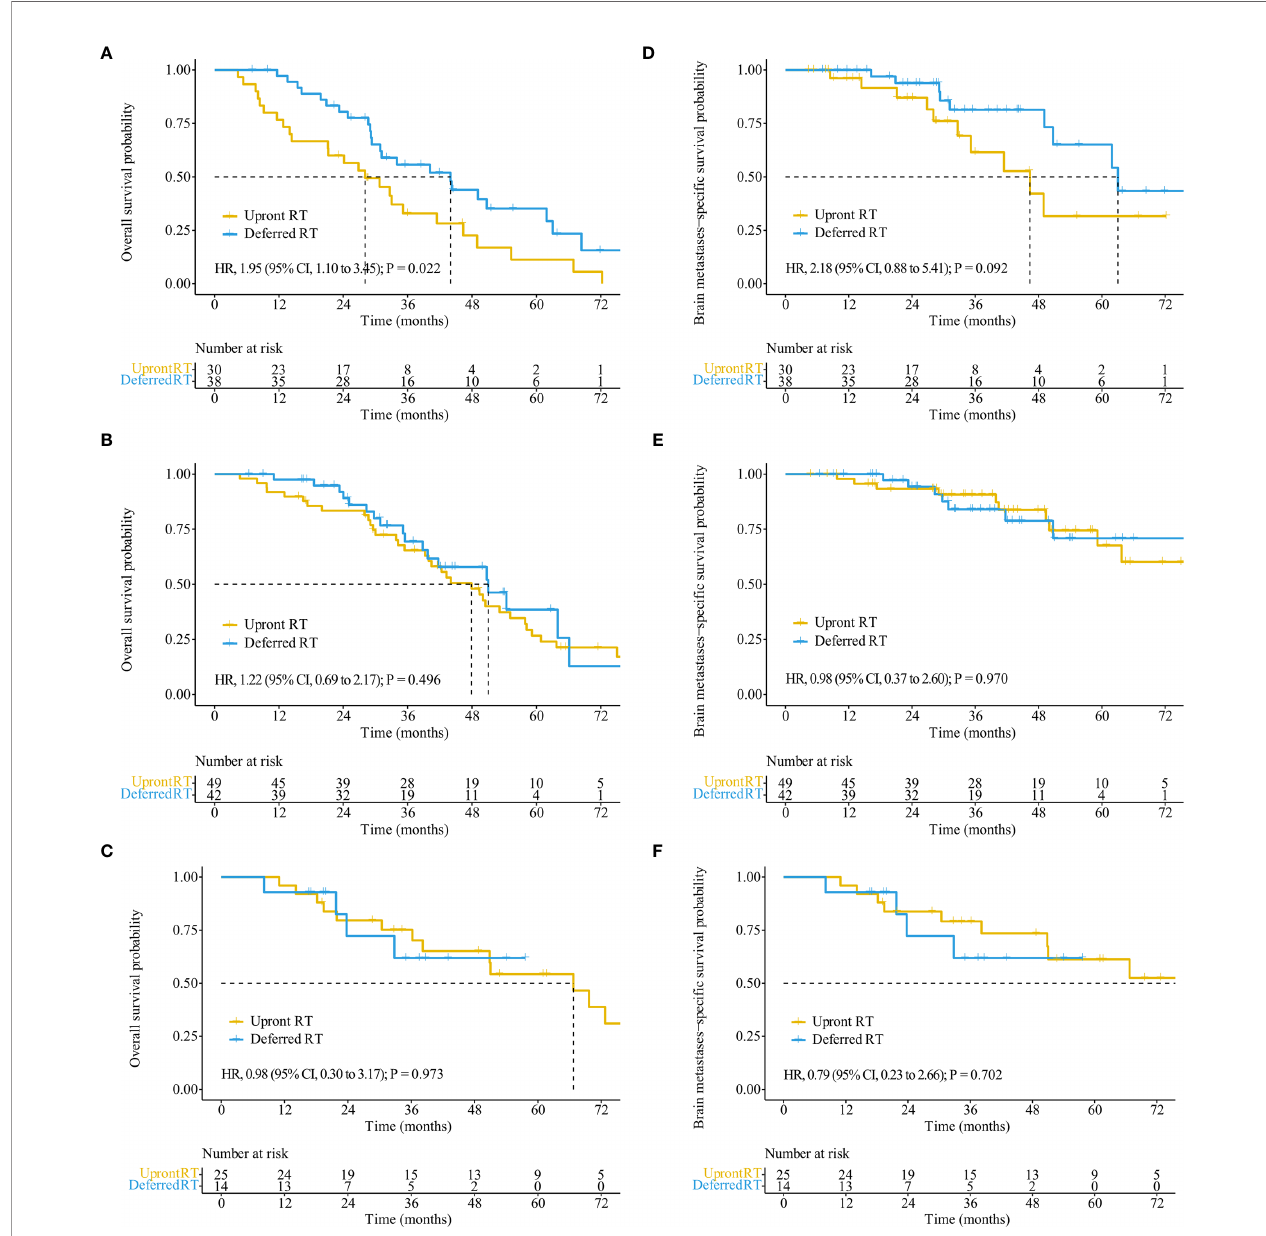
FIGURE 4 | OS andBMSS strati fi ed by treatment regimensin patients with different extracranial disease statuses. OS (A) andBMSS (D) of patients with progressed extracranial disease. OS (B) and BMSS (E) of patients with controlled extracranial disease. OS (C) and BMSS (F) ofpatients with non-extracranial